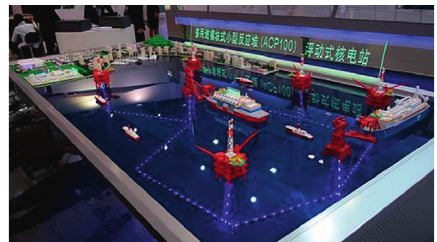
Figure 1: Working scenario of a floating nuclear power plant.